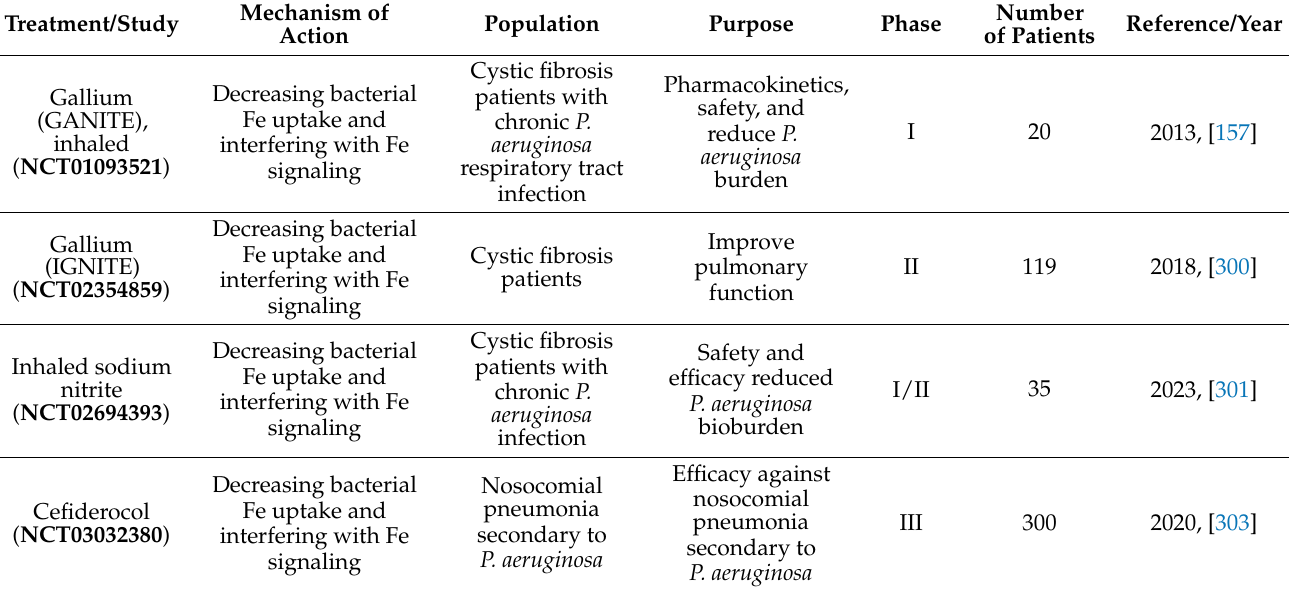
Table 6. Strategies targeting P. aeruginosa iron acquisition